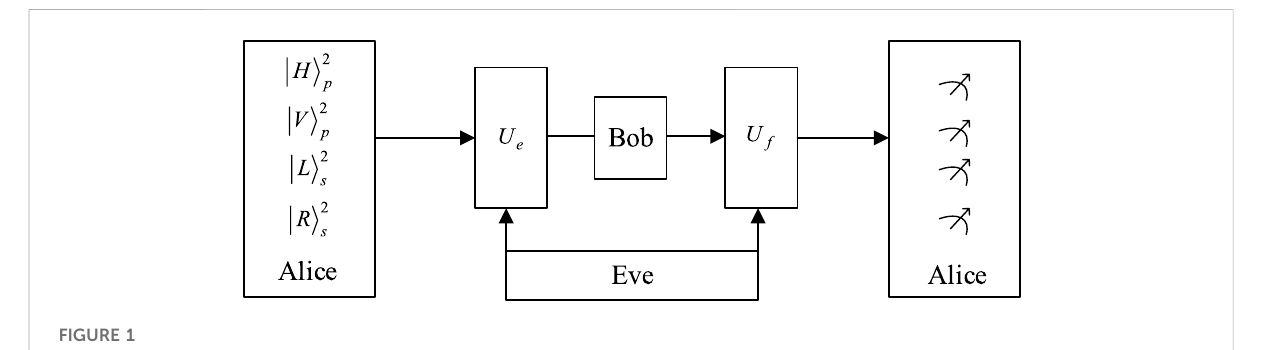
FIGURE 1 Entangle – measure attacks with two operations U e and U f